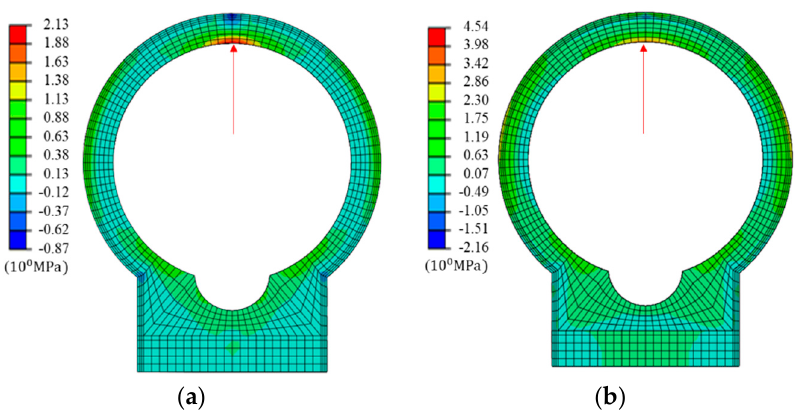
Figure 14. Tensile stress distribution of model 1 ( a ) and 2 ( b ).